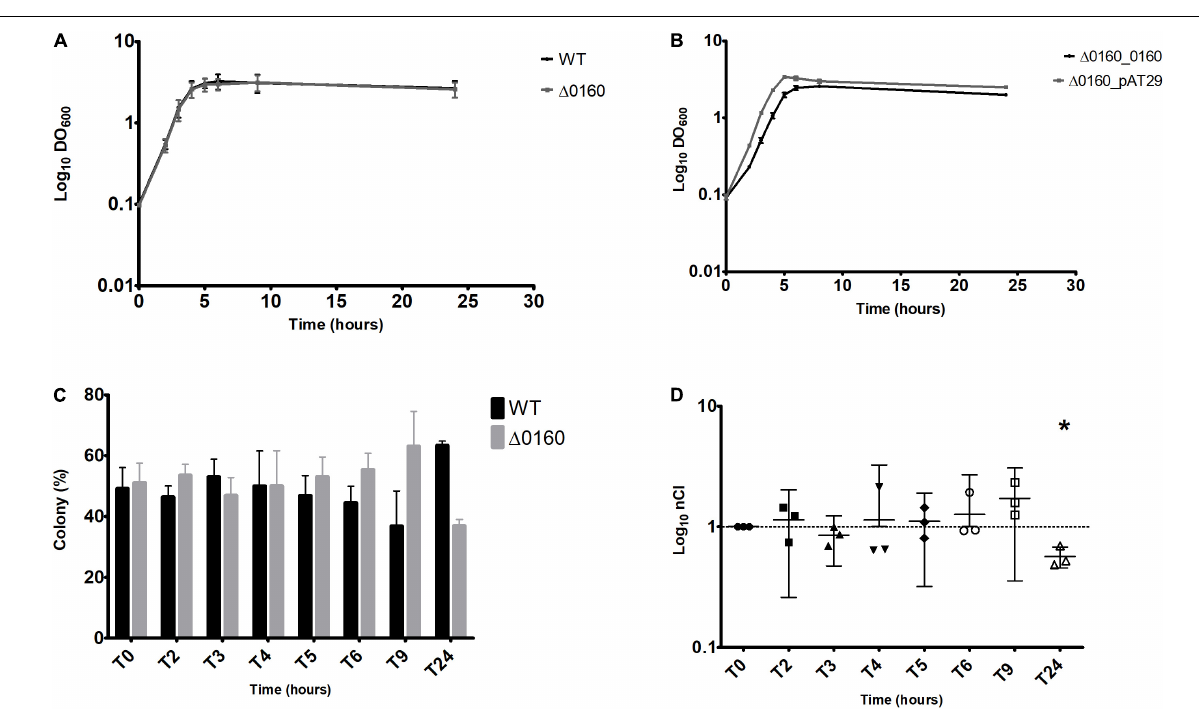
between the two strains, and (cid:49) 0160_0160 grew more slowly than (cid:49) 0160_pAT29. Moreover, the maximum DO (cid:49) 0160_0160 bacterial